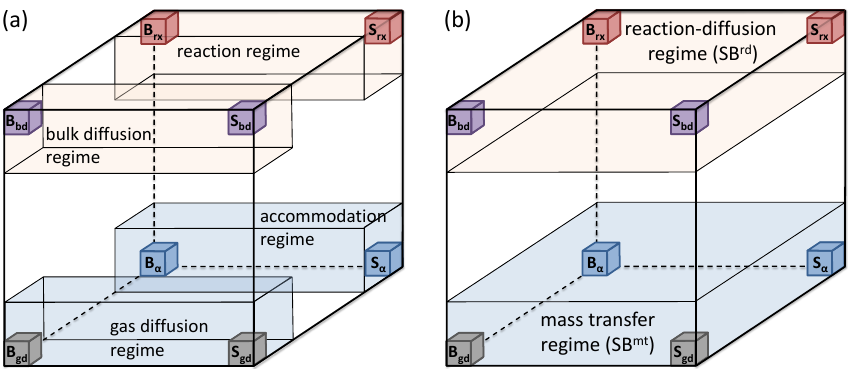
Fig. 3. Visualization of regimes as volumes of the kinetic cube in Fig. 2. (a) shows regimes resulting from the connection of each surface and bulk case. Regime names indicate the limiting process (the reaction regime is limited by reaction rate coefficients etc.). (b) shows a combination of the regimes in (a) in which the reaction and bulk diffusion regimes together form the reaction-diffusion regime and the accommodation and gas diffusion regimes together form the mass transfer regime.